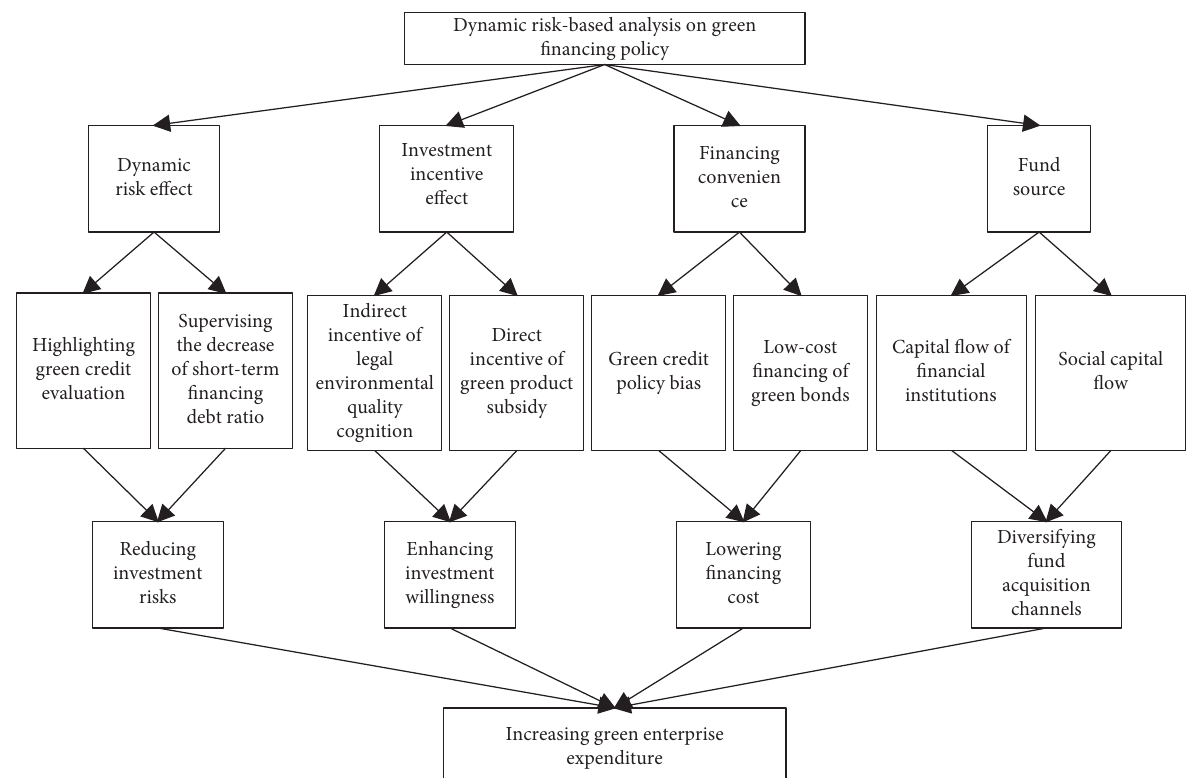
Figure 2: Associations between green financing and green corporate investment level.